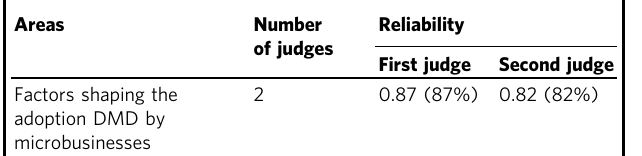
Table 4 Reliability